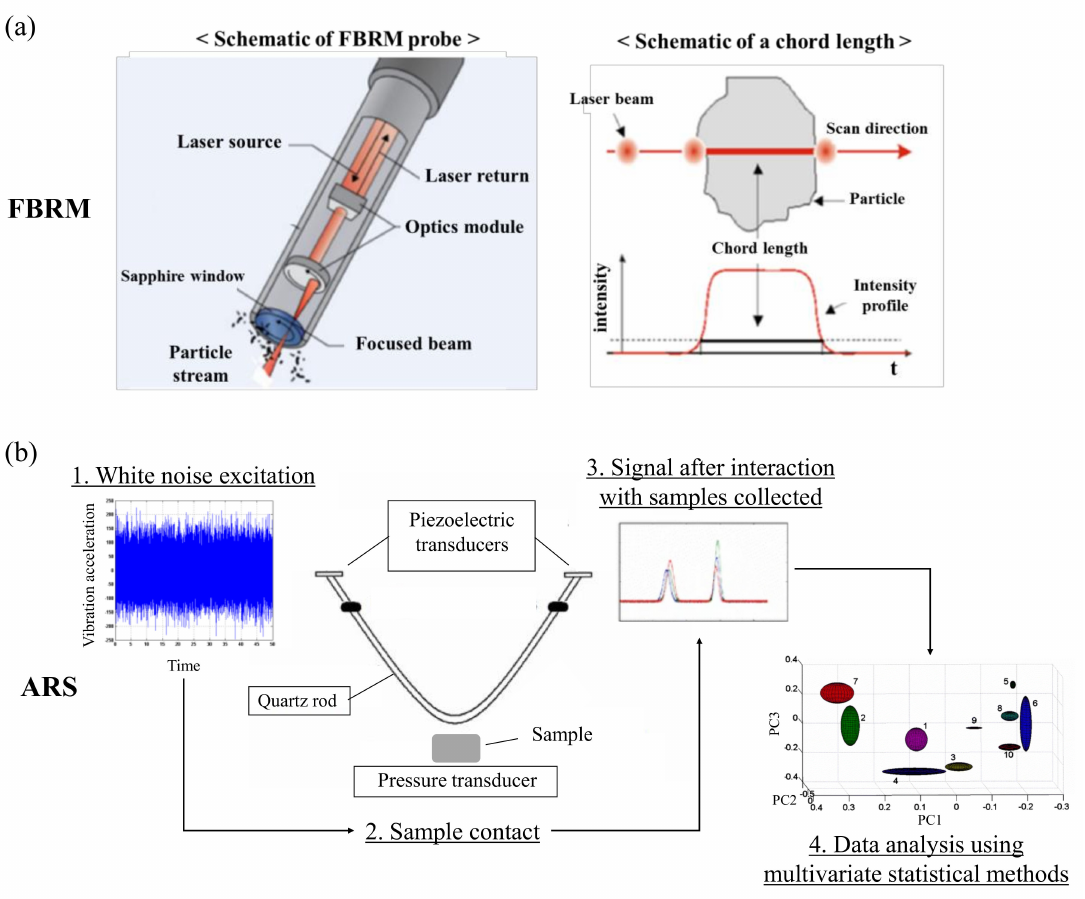
Figure 2. ( a ) Measuring principle of focused beam reflectance measurement (FBRM) [62]; ( b ) measuring principle of acoustic-resonance spectrometry (ARS) [63]. Slightly modified, with permission from Elsevier and Springer,